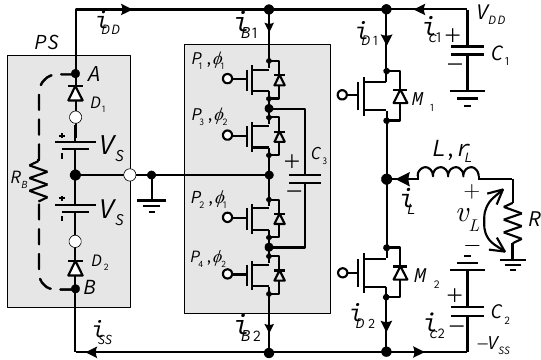
Figure 6. Principal schematic of class-D HB amplifier without control circuitry. The amplifier is powered with unidirectional power supply and augmented with bus-pumping (BP) switched-capacitor (SC) suppression circuit. Resistor R B is disconnected during regular operation of the amplifier. The total resistance R is the sum of the coil resistance r L and the load resistance R L : R = R L + r L